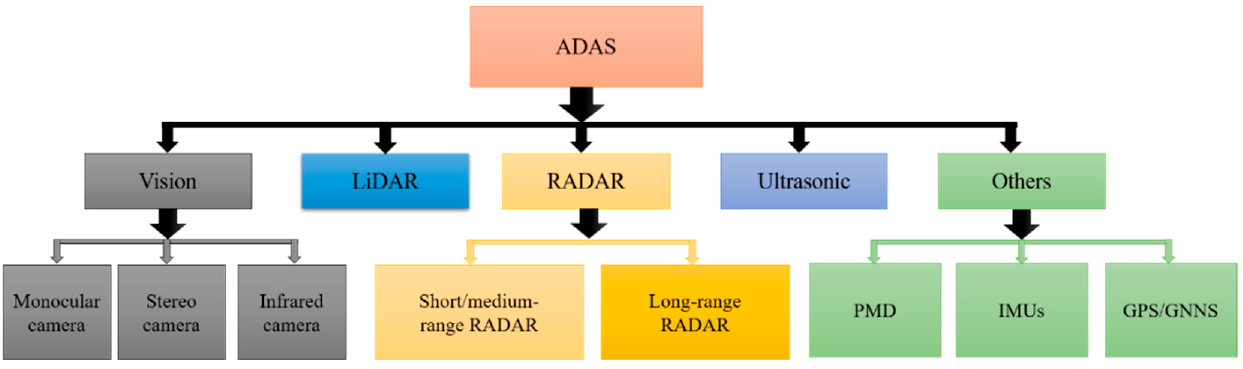
Figure 3. Taxonomy of advanced driver assistance systems (ADASs) based on the model of sensors.